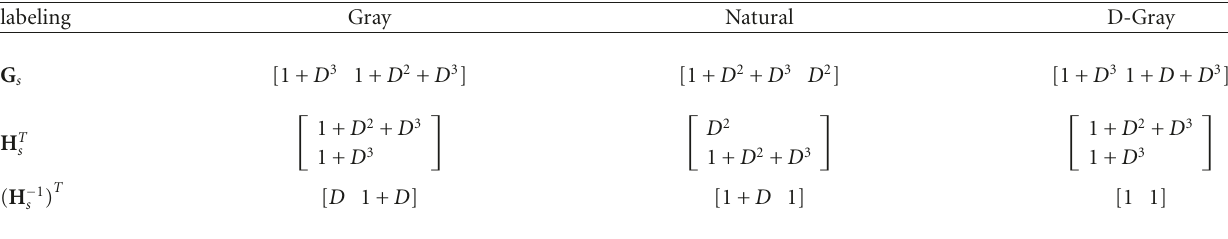
Table 1: The optimum parameters for n s = 2 with 32-PSK.